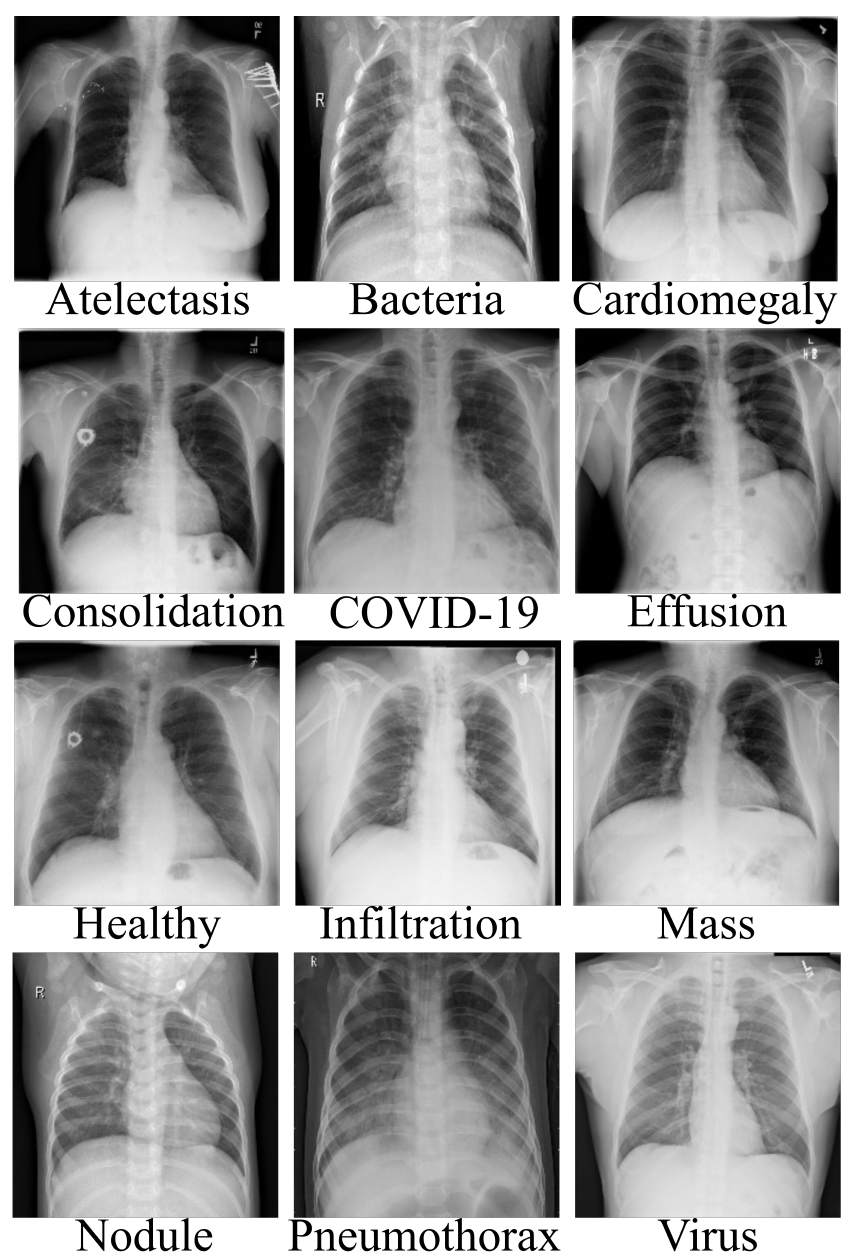
Figure 2. Data description of different pneumonia diseases, including COVID-19.